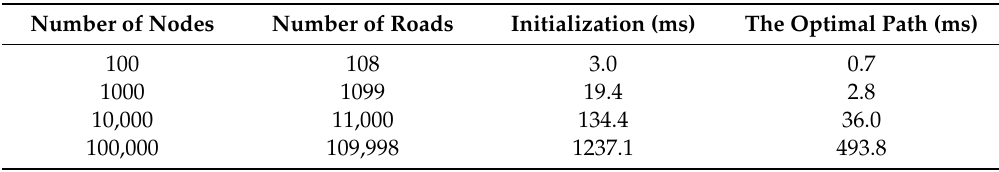
Table 2. Running time under di ff erent problem